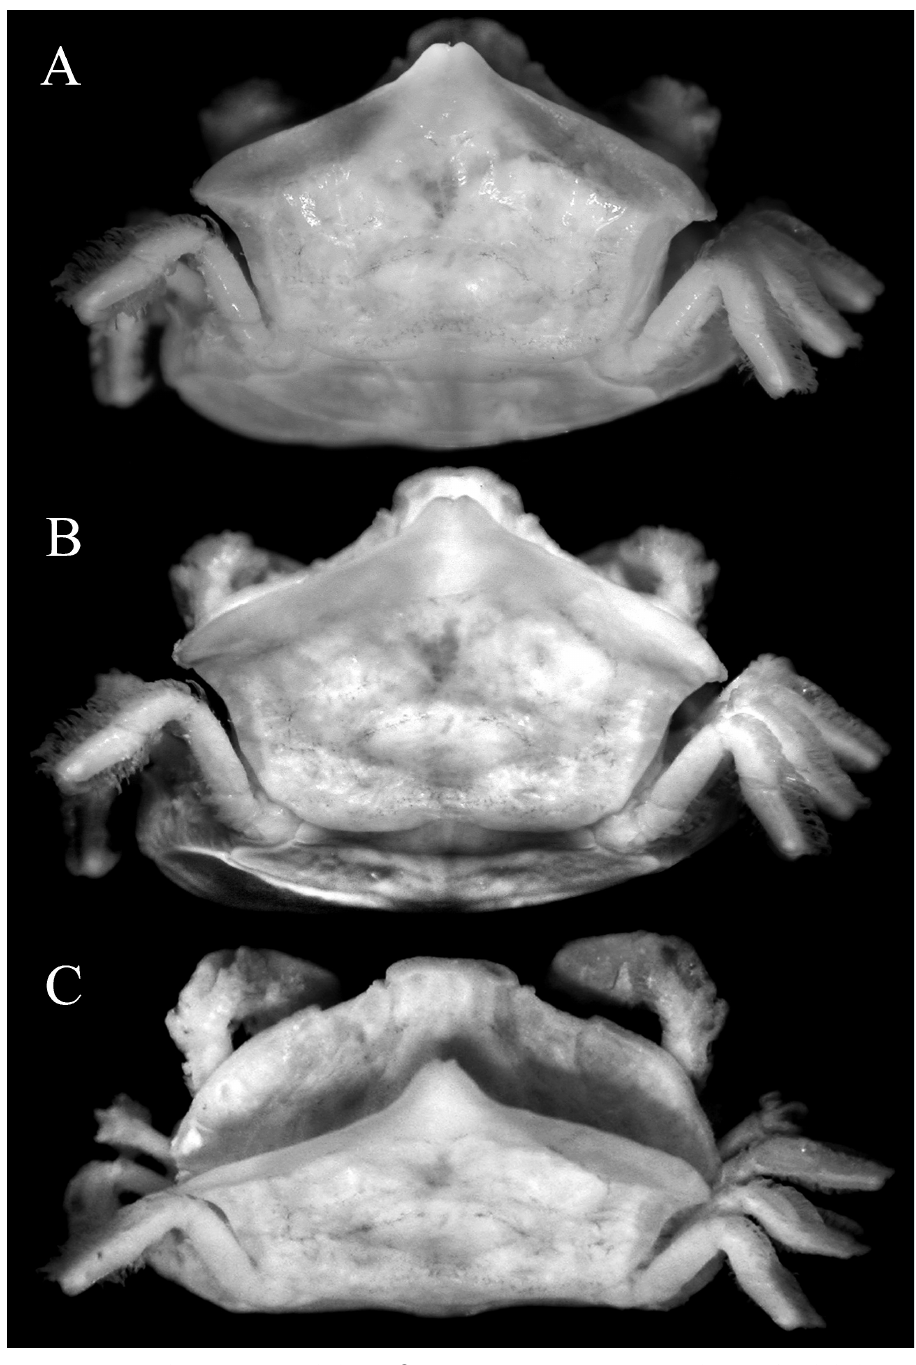
Figure 2. Serenotheres janus sp. n., holotype ♀ (8.9 × 7.9 mm) (USNM). Dorsal views of